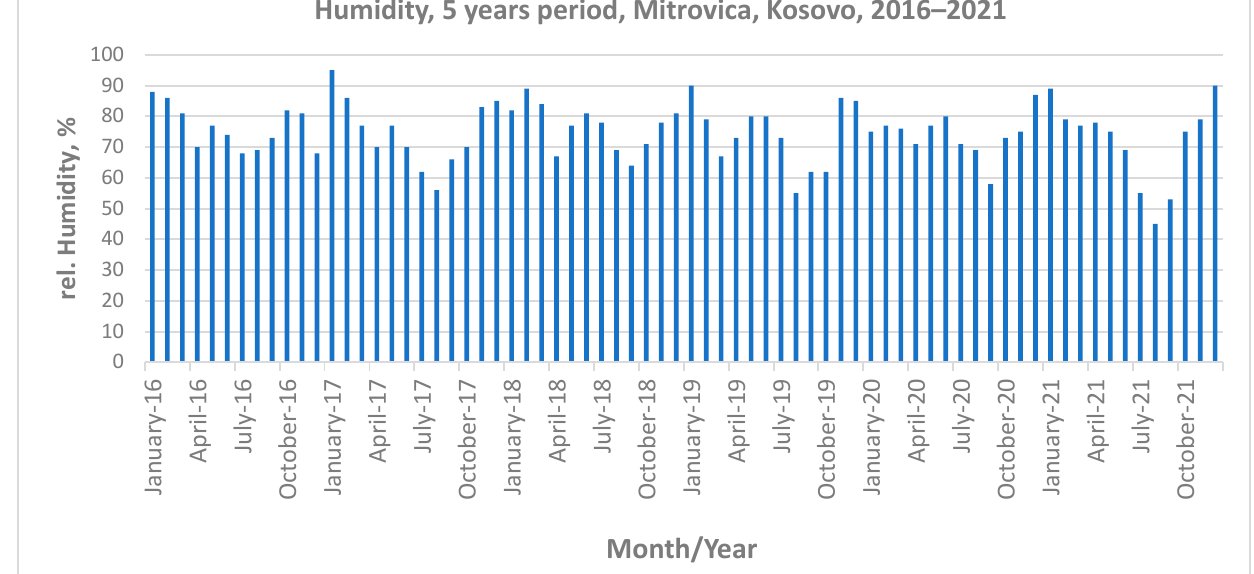
Figure 3. Average relative humidity data in a 5-year period in Mitrovica.